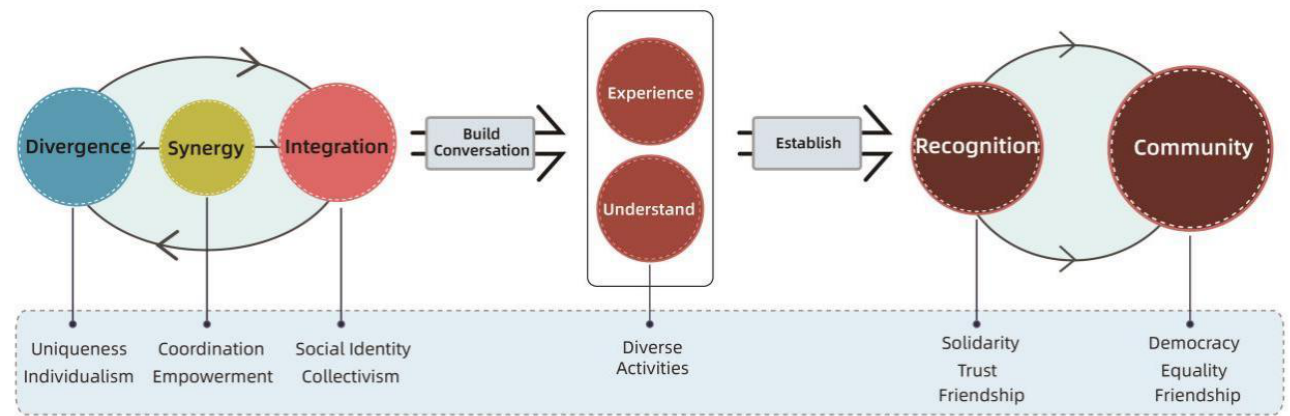
Figure 14. Theoretical system model of intergenerational integration accommodation strategies.